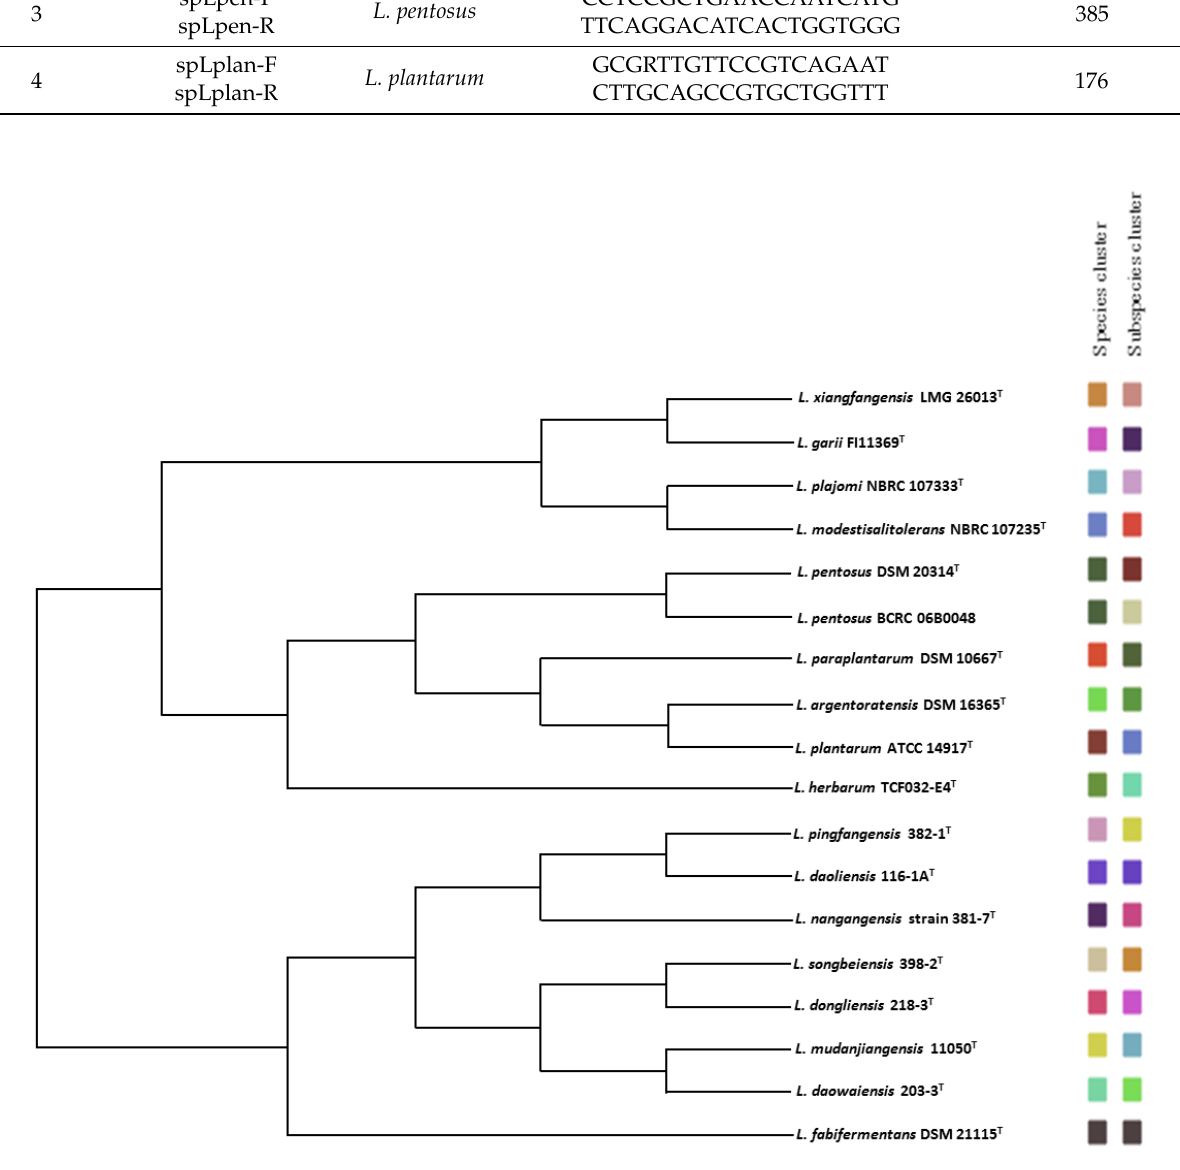
Figure 2. Phylogenomic tree of the 18 L. plantarum group strains available on the TYGS database. The tree was inferred with FastME 2.1.6.1 from GBDP distances calculated from genome sequences. The branch lengths are scaled in terms of GBDP distance formula d5. The tree was rooted at the midpoint. Accession numbers of the genome sequences used for the reconstruction are shown in Supplementary Table